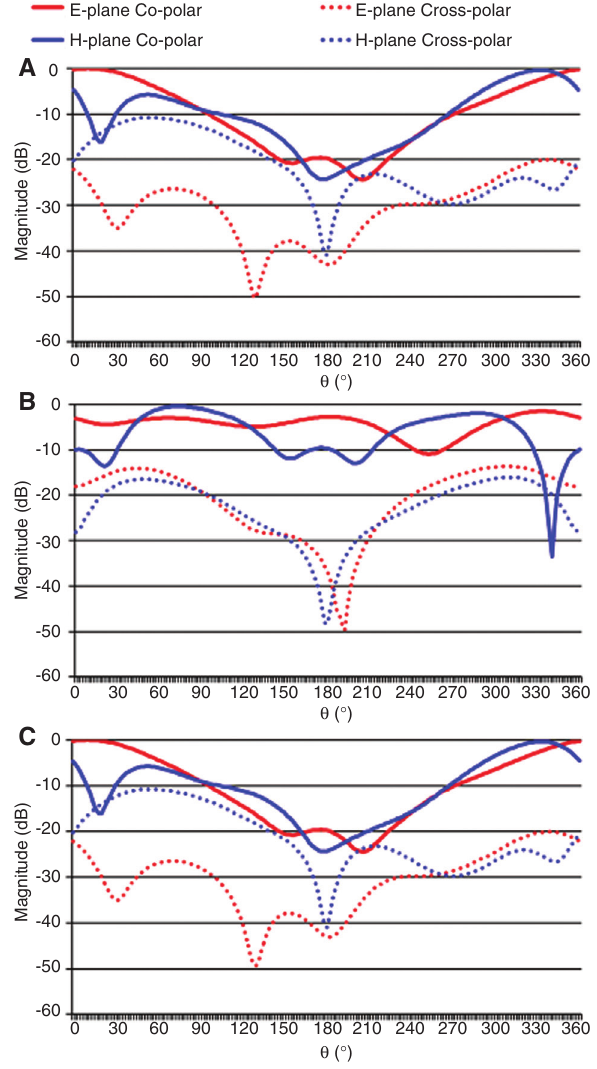
Figure 8 Measured radiation pattern at (A) 5.6 GHz, (B) 9.5 GHz, and (C) 10.9